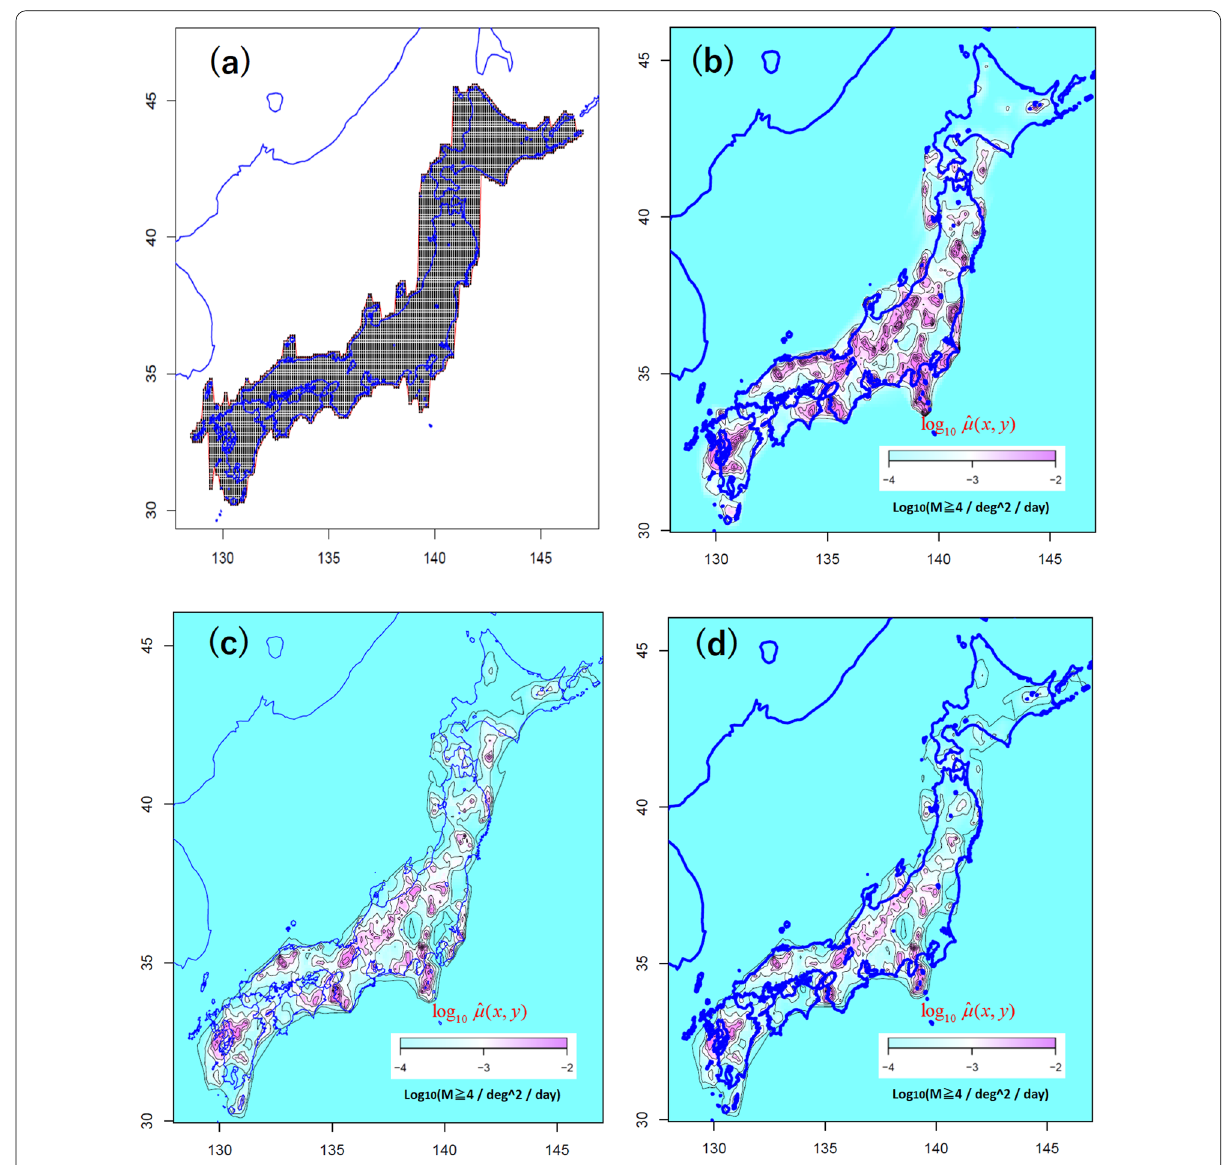
Fig. 3 Poisson space–time models for the long-term seismicity of inland Japan, all of which are shown by the respective MAP estimate that minimizes the ABIC: a inland uniform Poisson process model, b nonuniform spatial Poisson process model, c background μ ( x , y ) intensities of the HIST–ETAS– μK model, and d HIST–ETAS–5pa model. The colors and contours are in logarithmic scale indicating the expected number of M earthquakes/deg 2